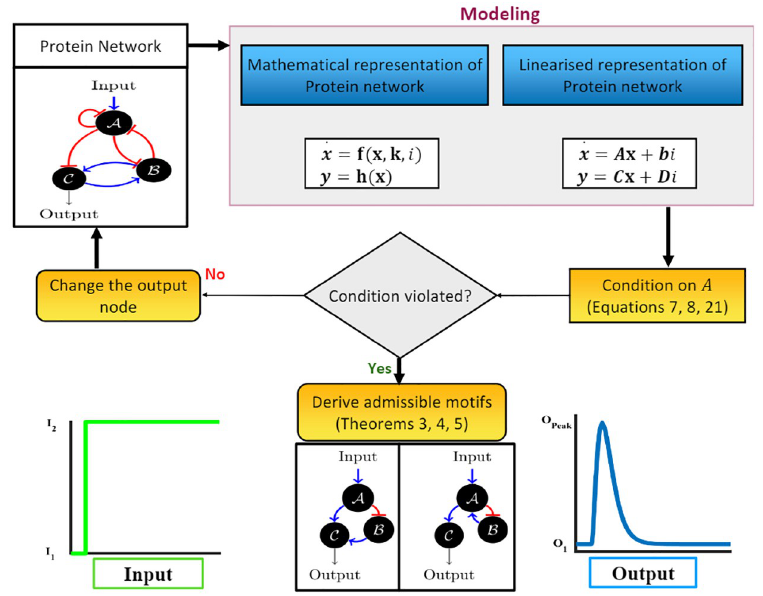
Fig 2. Workflow of the proposed methodology. Any given protein network is first linearized, and the conditions on the A matrix are investigated, to ultimately derive admissible motifs for the desired